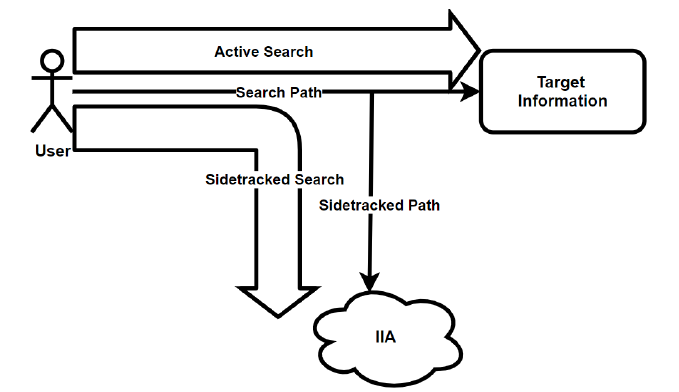
Figure 1. The structure of a serendipitous